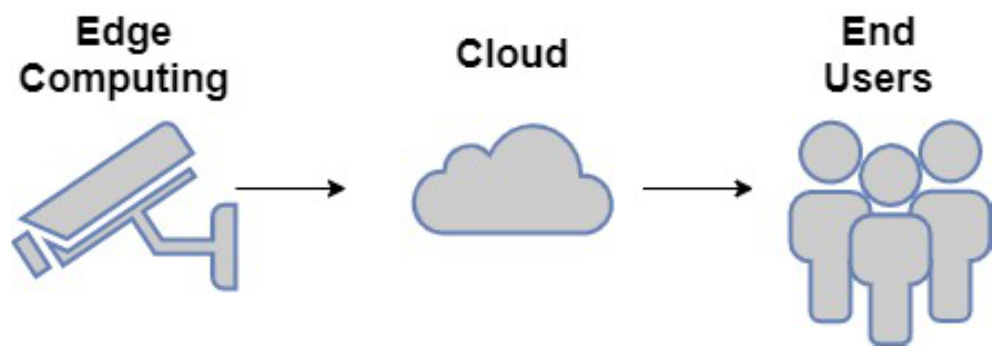
Figure 1. Complete System Architecture.